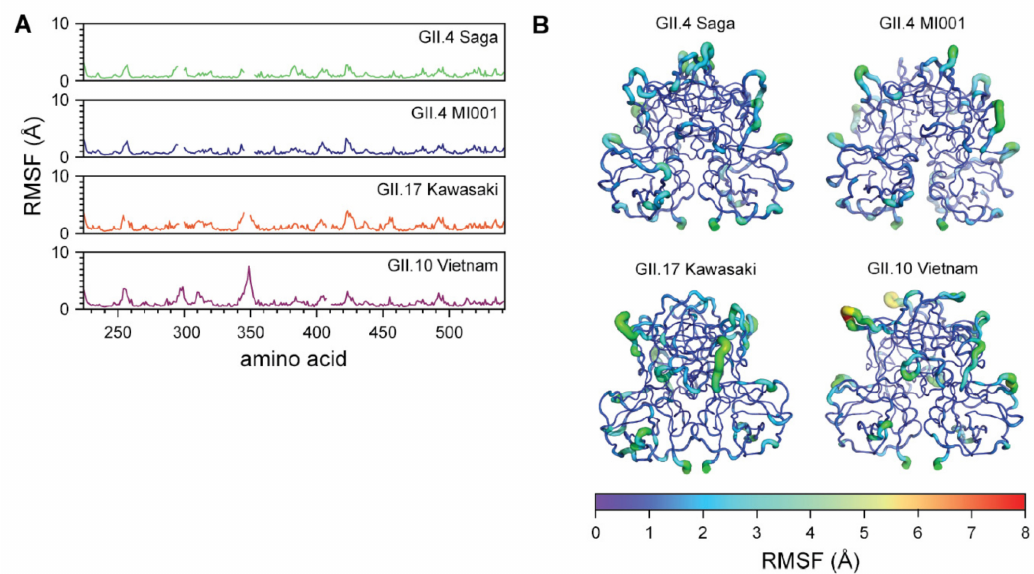
Figure 5. Difference in fluctuations between the P dimer strains propose increased flexibility in the protein chains in absence of a ligand. ( A ) RMSF data of GII.4 Saga, GII.4 MI001, GII.17 Kawasaki and GII.10 Vietnam, simulated for a total of 1 µ